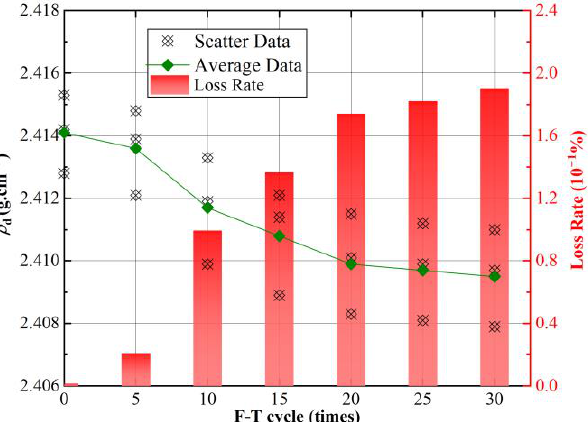
Figure 9. The average dry density and loss rate with cycles in the tested sandstone.